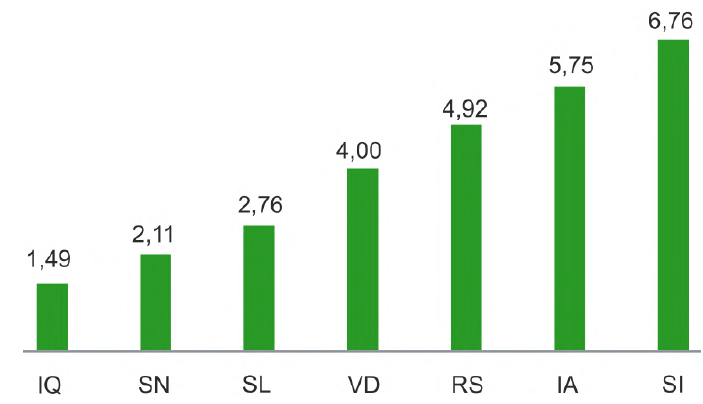
Figure 70: Presentation of paper